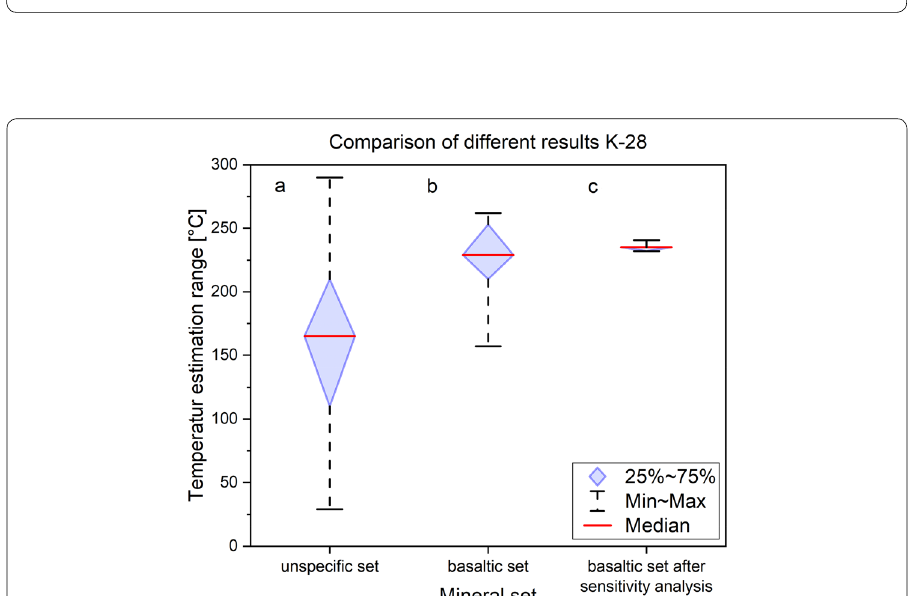
Fig. 6 Comparison of an unspecific mineral set (a) with the developed basaltic set (b). The boxplot in the third column (c) is the result of the combination of the pH, aluminium concentration, and steam loss sensitivity analysis. All analyses are done separately under static conditions for the remaining parameters, and all best-fit parameters were combined